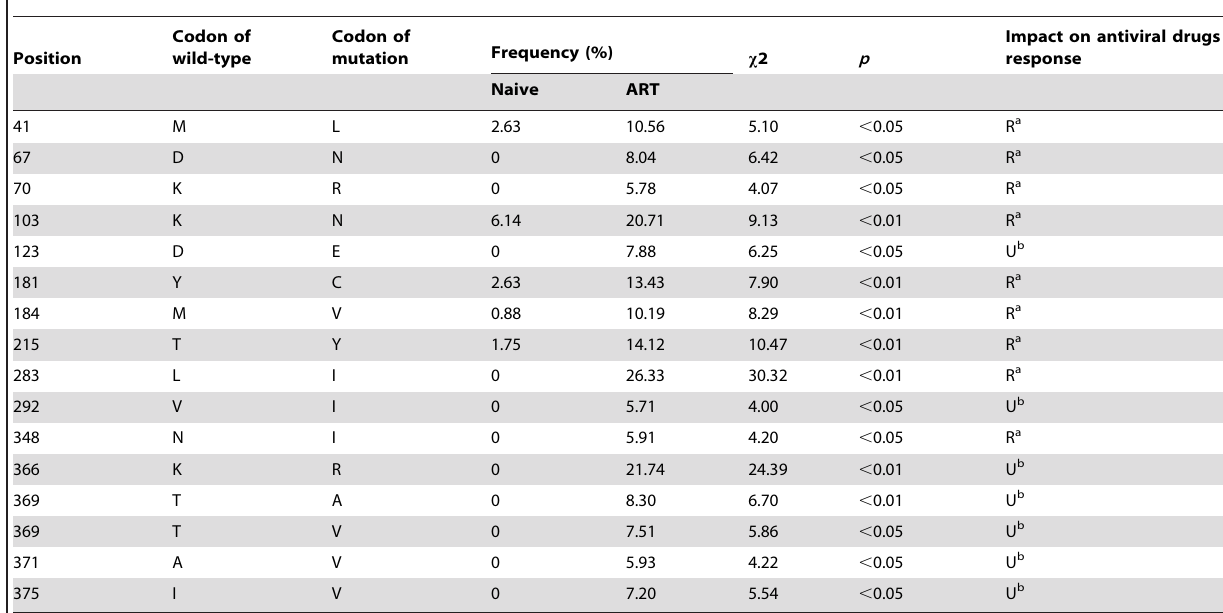
Table 2. 16 significant mutations between the ART and the naı¨ve-therapy population.